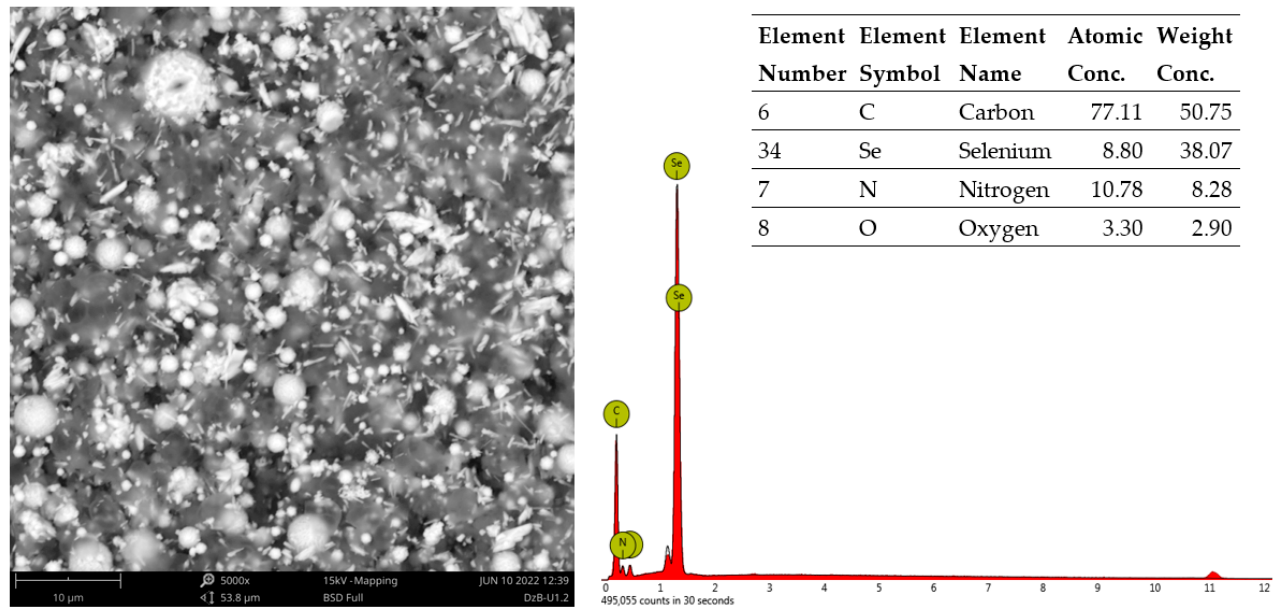
Figure 3. Scanning electron microscopy micrograph of selenium nanoparticles and energy-dispersive X-ray elemental analysis of synthesised sample of selenium nanoparticles.